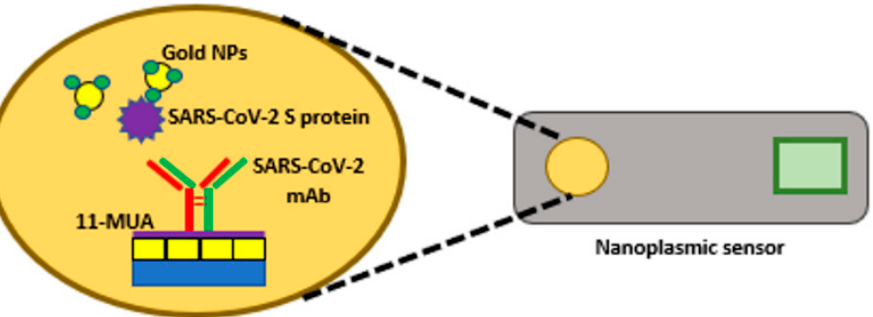
Figure 7. Schematic diagram of nano-plasmonic sensor chip cartridge used to detect SARS-CoV-2 using a sensor chip cartridge.